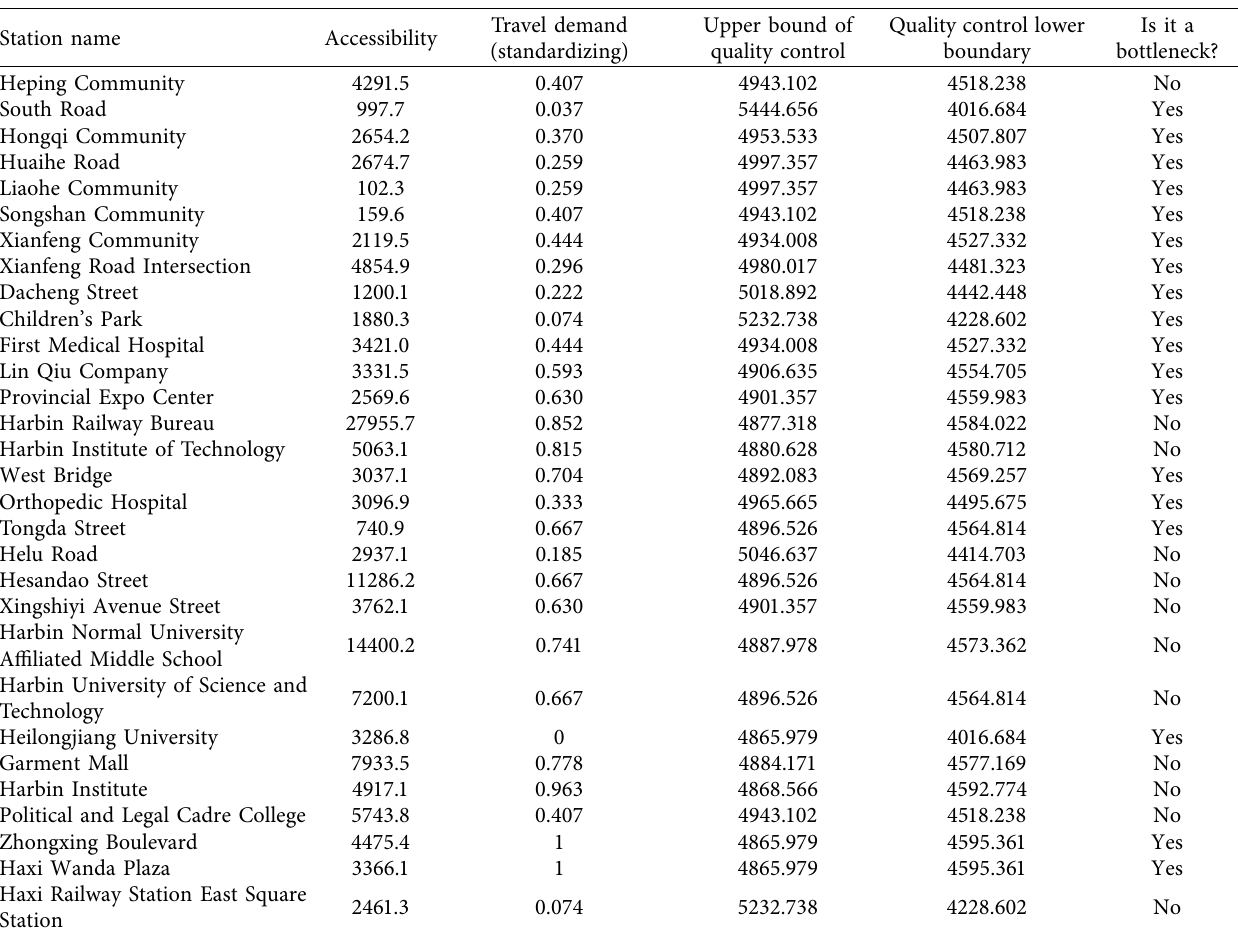
Table 2: The abnormal station determines the